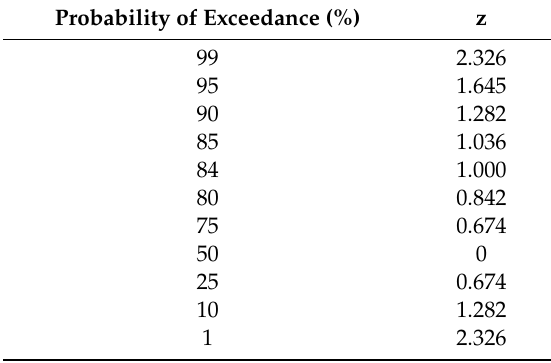
Table 5. Normal distribution of specific probabilities and their corresponding z values